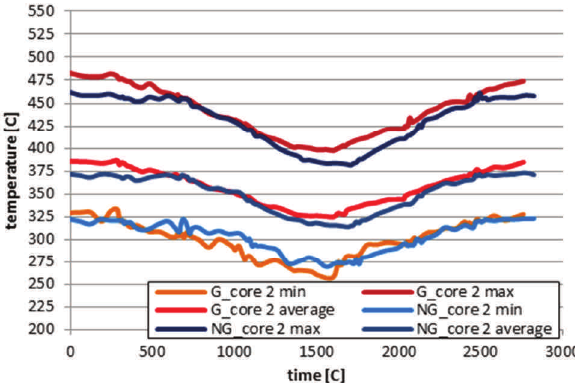
Fig. 4. Temperature values on the surface of the first core derived from thermo-grams